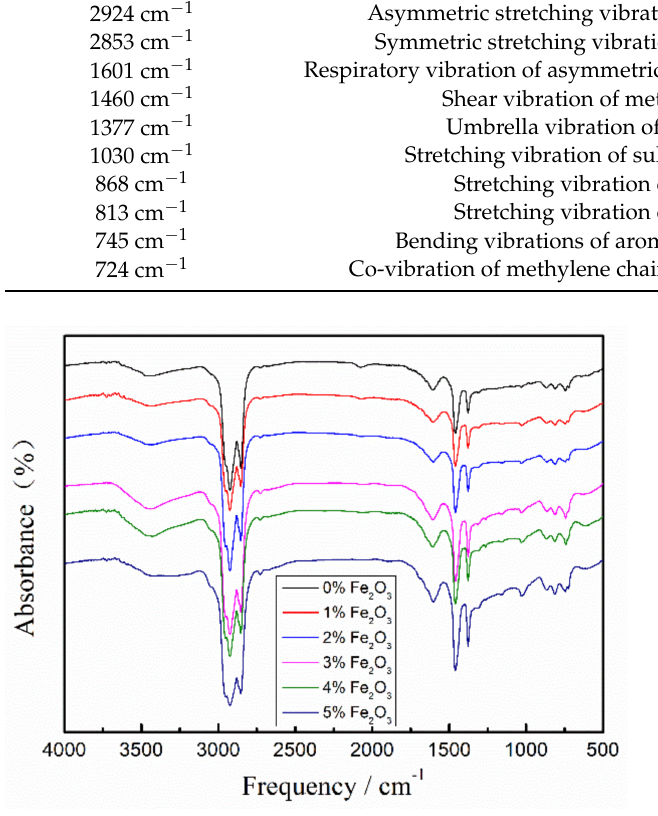
Figure 4. FTIR maps of modified asphalt with different Nano-Fe 2 O 3